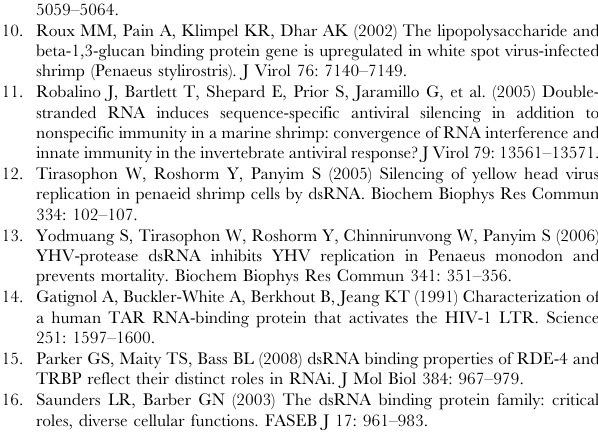
Figure S3 Native PAGE and Western blot was performed to confirm the dimerization of TRBP-DC(left panel). After Native PAGE of TRBP-DA,-DB and DC, the proteins in the PAGE gel were transferred onto a nitrocellulose membrane and were